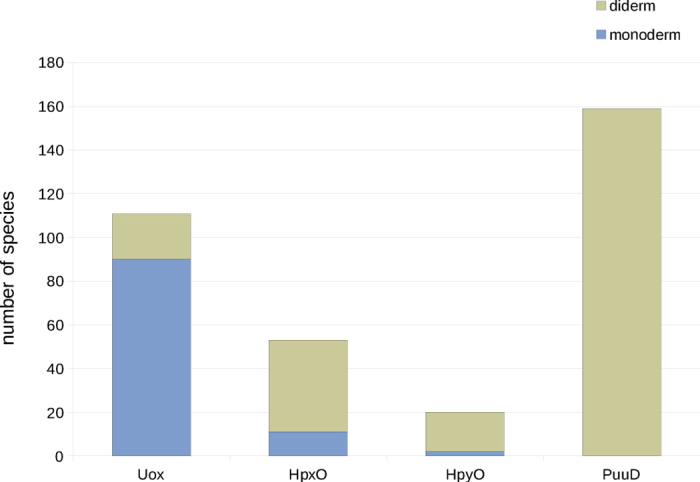
Distribution of urate oxidation genes in monoderm and diderm prokaryotes.The occurrence of the different genes for urate oxidation in 341 prokaryotic species (see Fig. 1c) classified based on the presence of a single (monoderm) or a double (diderm) cell membrane40.